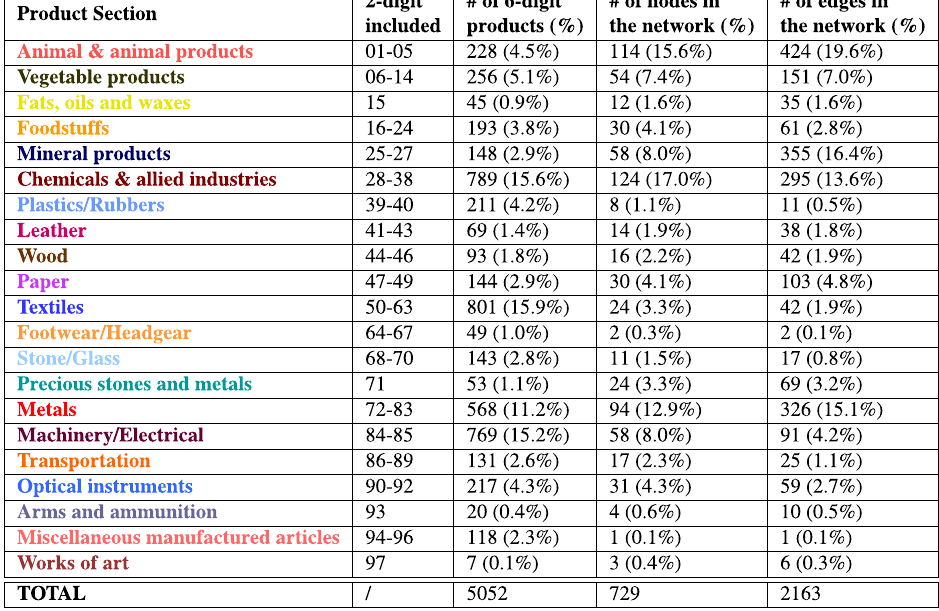
nd − 3 rd columns: which 2-digit